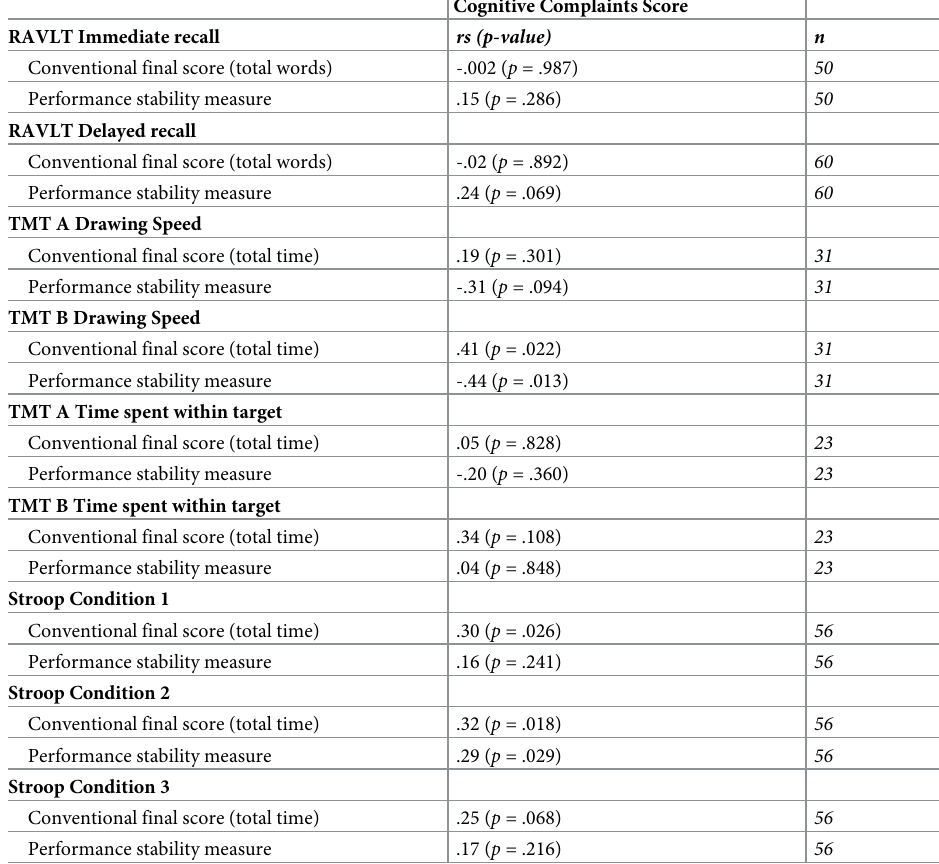
Cognitive Complaints Score